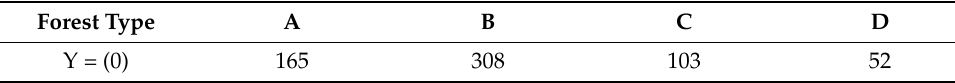
Table 1. Values of the dependent variable Y for each forest